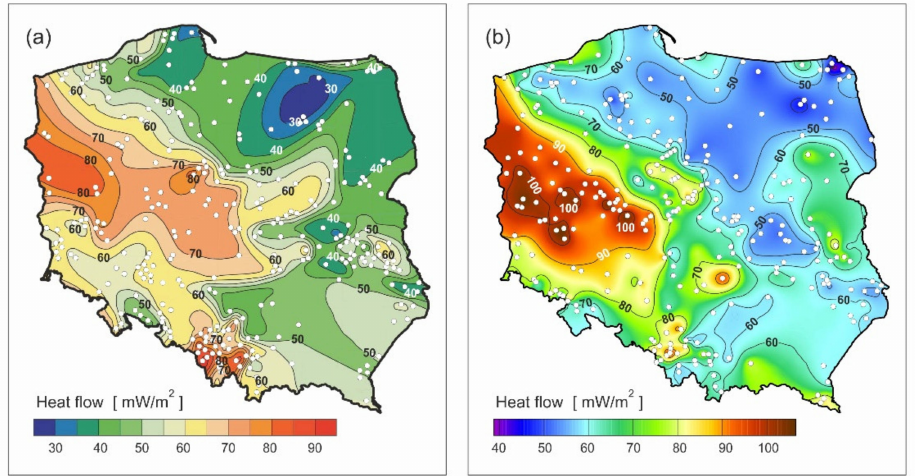
Figure 4. Heat flow maps of Poland according to Karwasiecka and Bruszewska [12]) ( a ) and Szewczyk and Gientka [17] ( b ). Note some 20–30 mWm − 2 difference in average heat flow magnitudes between both maps. The original maps were redrafted and modified for common graphics (free software for mapping is from